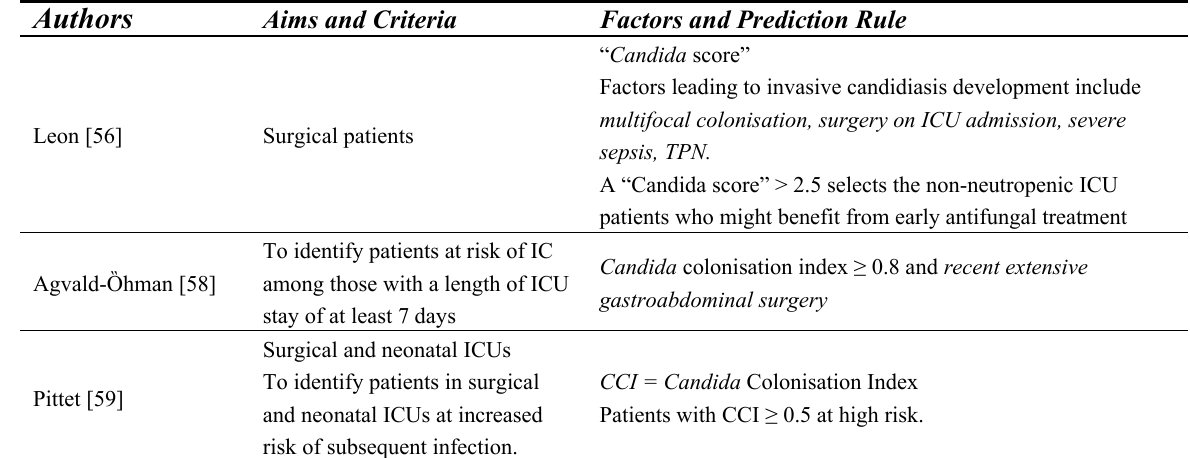
Table 3 . Candida Prediction